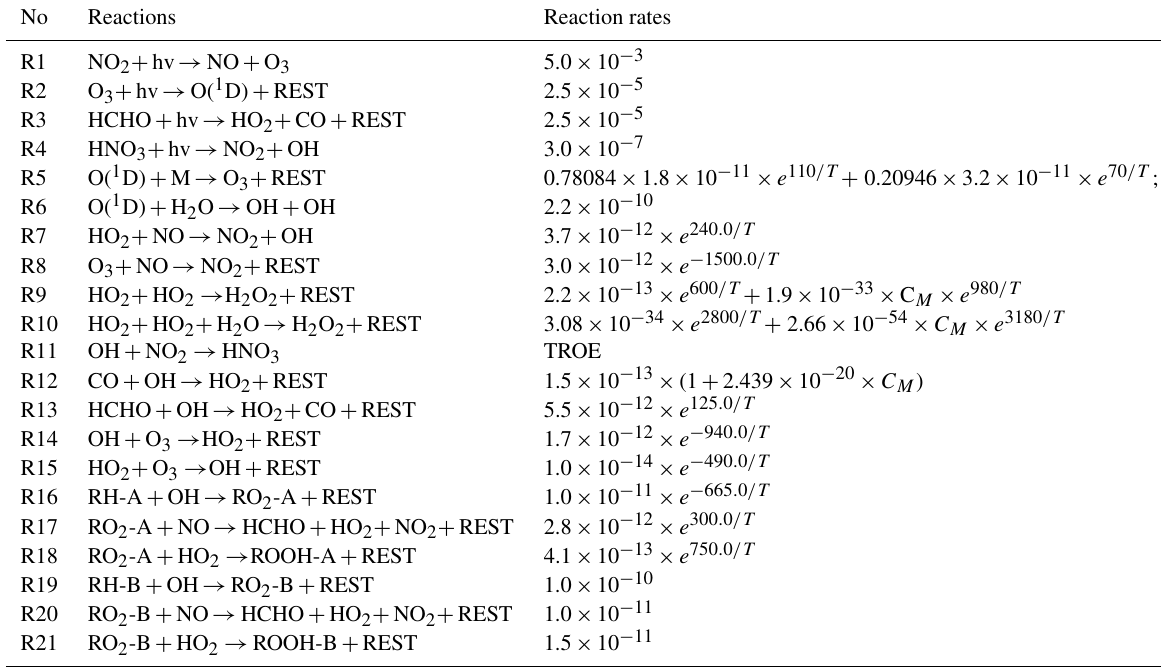
Table 1. The chemical reactions used in the model. The unit of first-order reaction rate coefficients is per second (s − 1 ) and that of second-